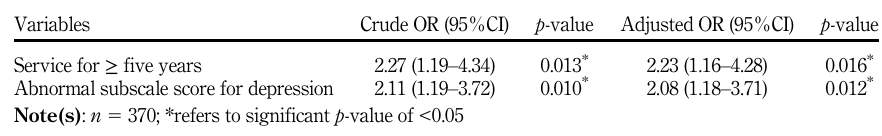
multivariable binary logistic regression